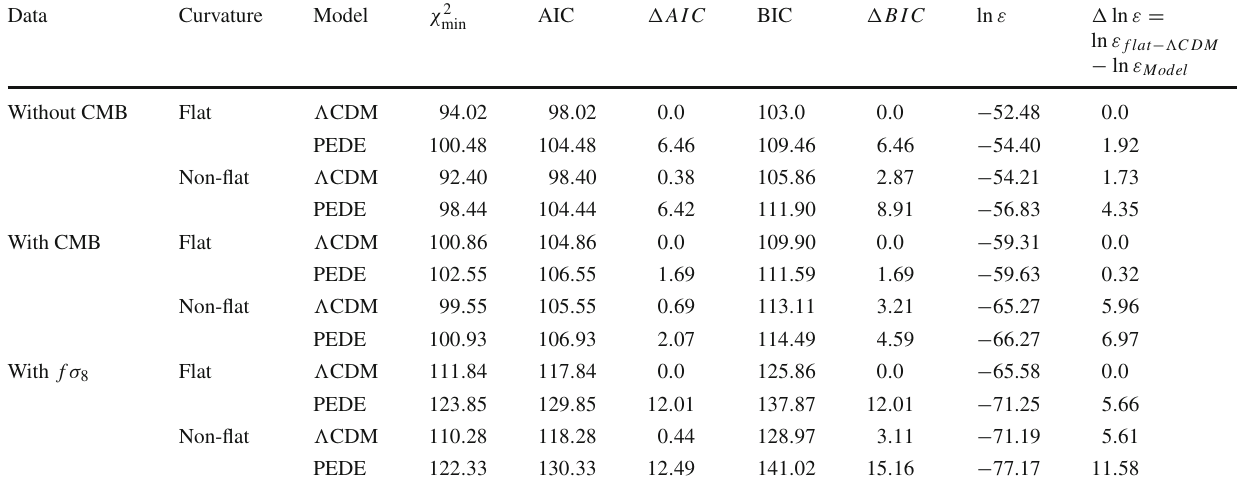
Table 6 The statistical results of the analysis for different cosmologies considered in this work using different data sets Data Curvature Model